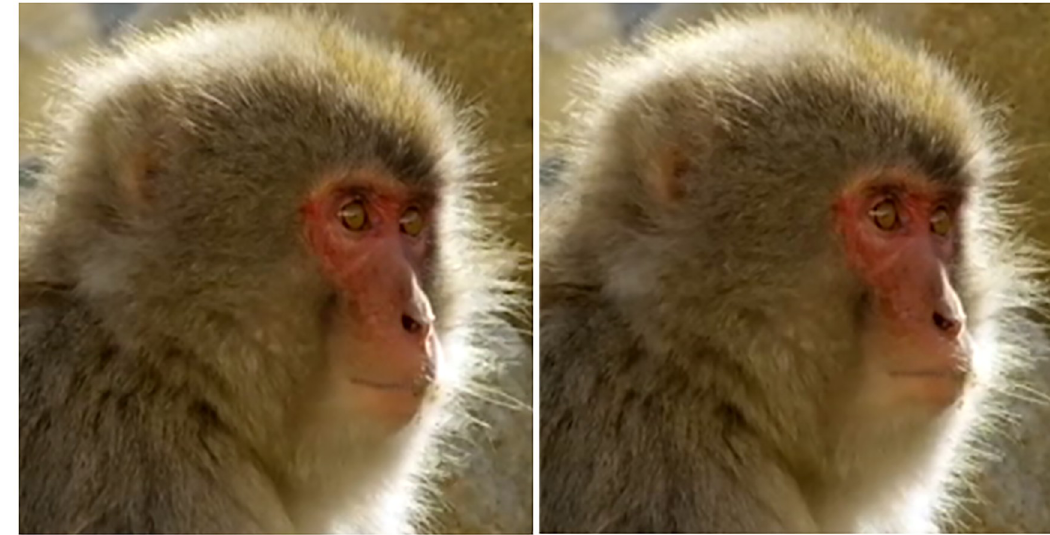
Fig 11. Left: Neutral; Right: AU17, slightly pushing the upper